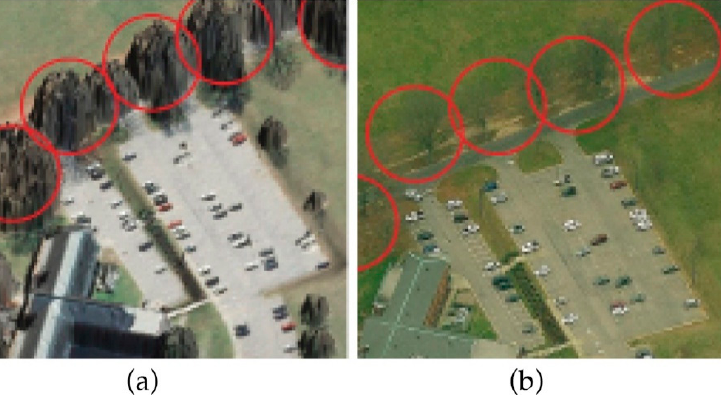
Figure 1. Representation of deciduous trees in lidar derived digital surface models (DSM) ( a ) and bird-view imagery ( b ) in leaf-off season.